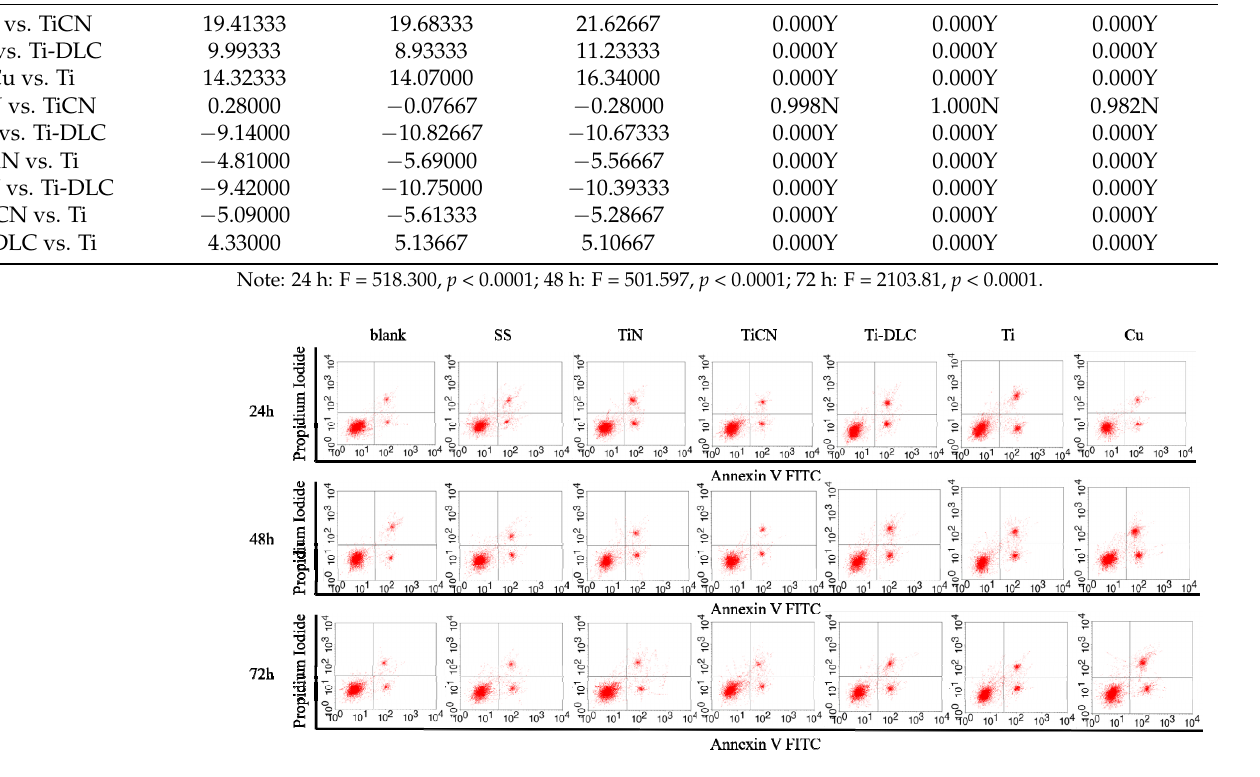
Figure 7. Flow cytometry of samples after 24, 48, and 72 h of incubation.